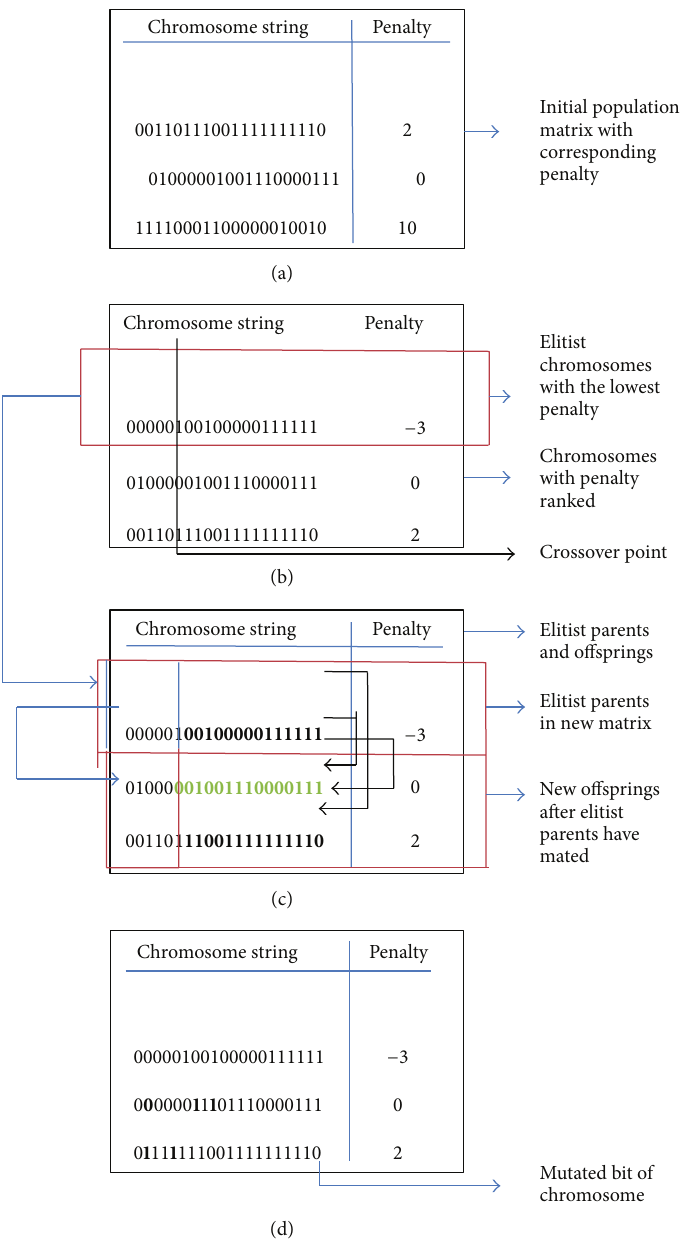
Figure 5: Illustration of MIGA